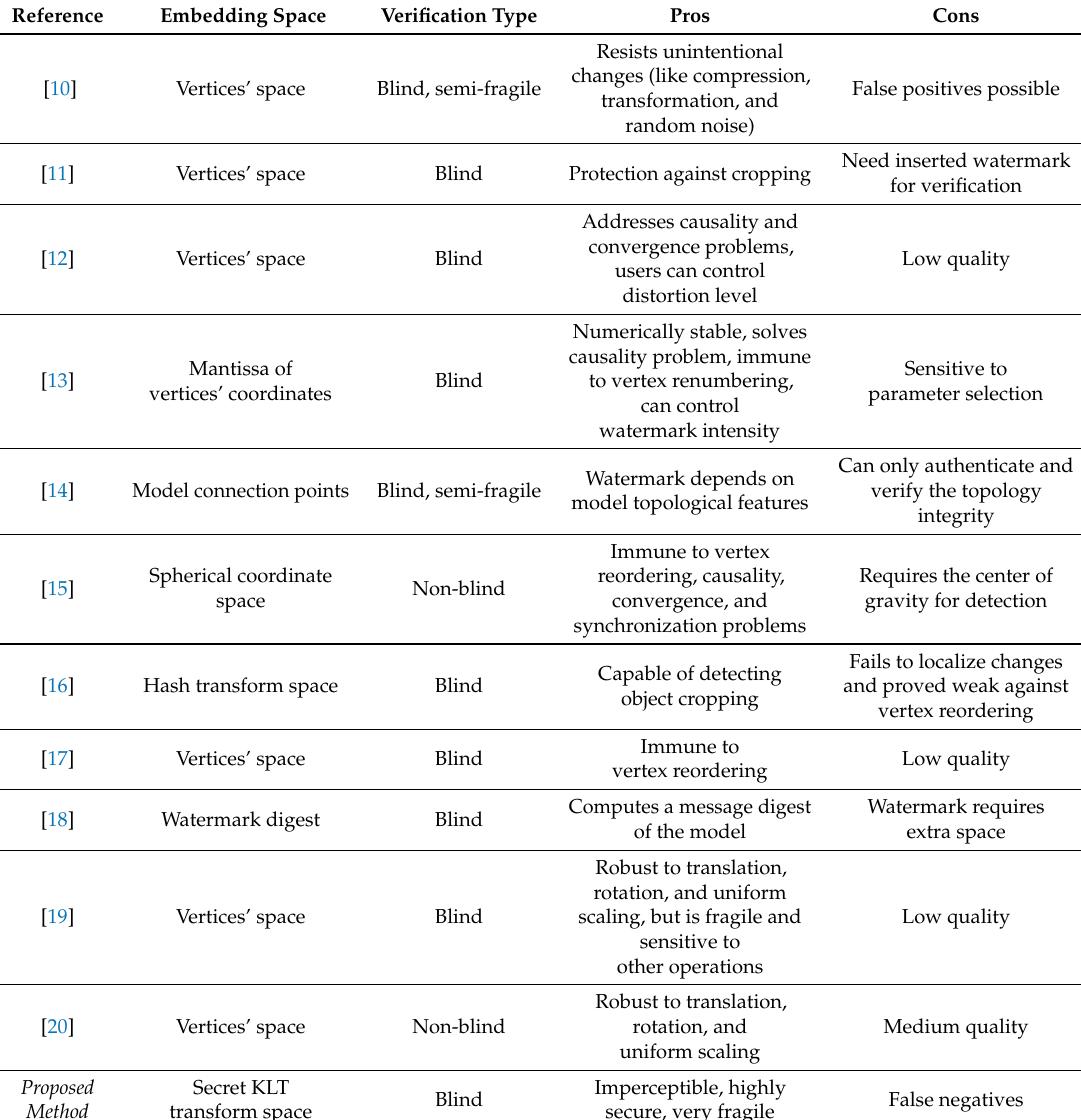
Table 2. Summary of related works on fragile watermarking: main properties, pros, and cons. KLT, Karhunen–Loève